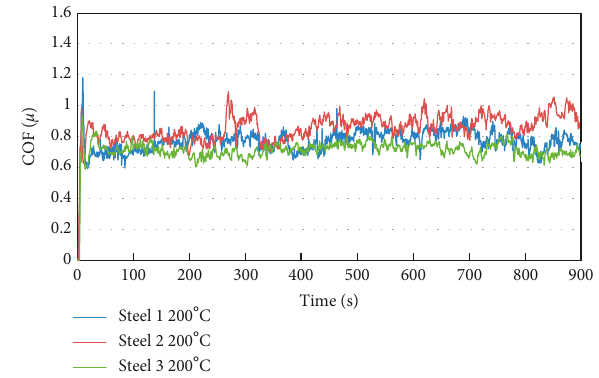
Figure 4: COF of the tests performed at 200 ° C.